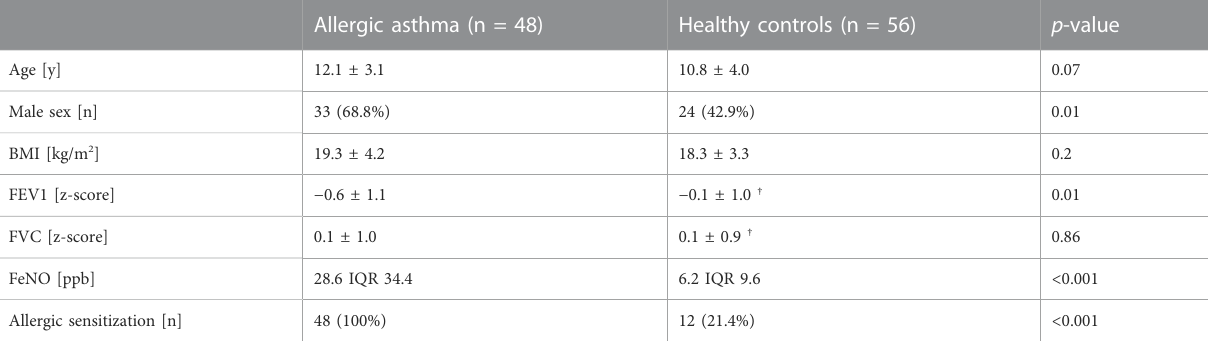
TABLE 1 Participant